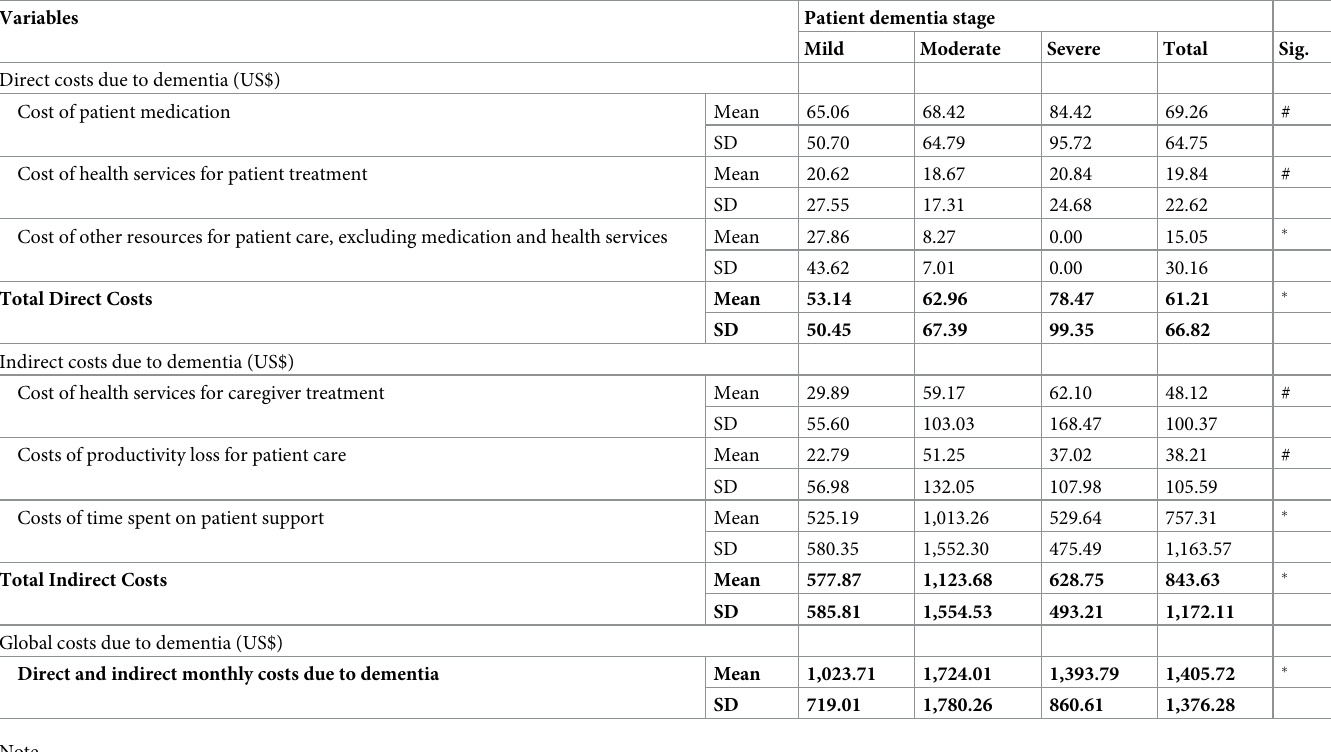
Table 5. Monthly direct, indirect and global costs due to dementia and regression model with caregiver burden, according to patient FAST category. Brazil, 2016. Variables